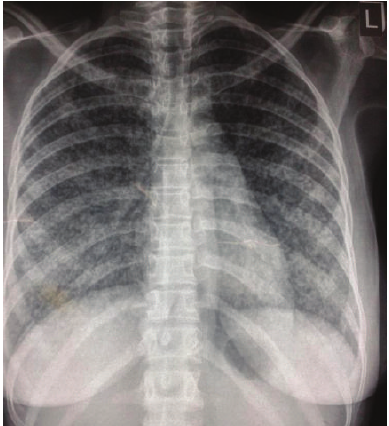
Figure 1: Chest radiograph showing widespread (whole lung) retic- uloalveolar “miliary”